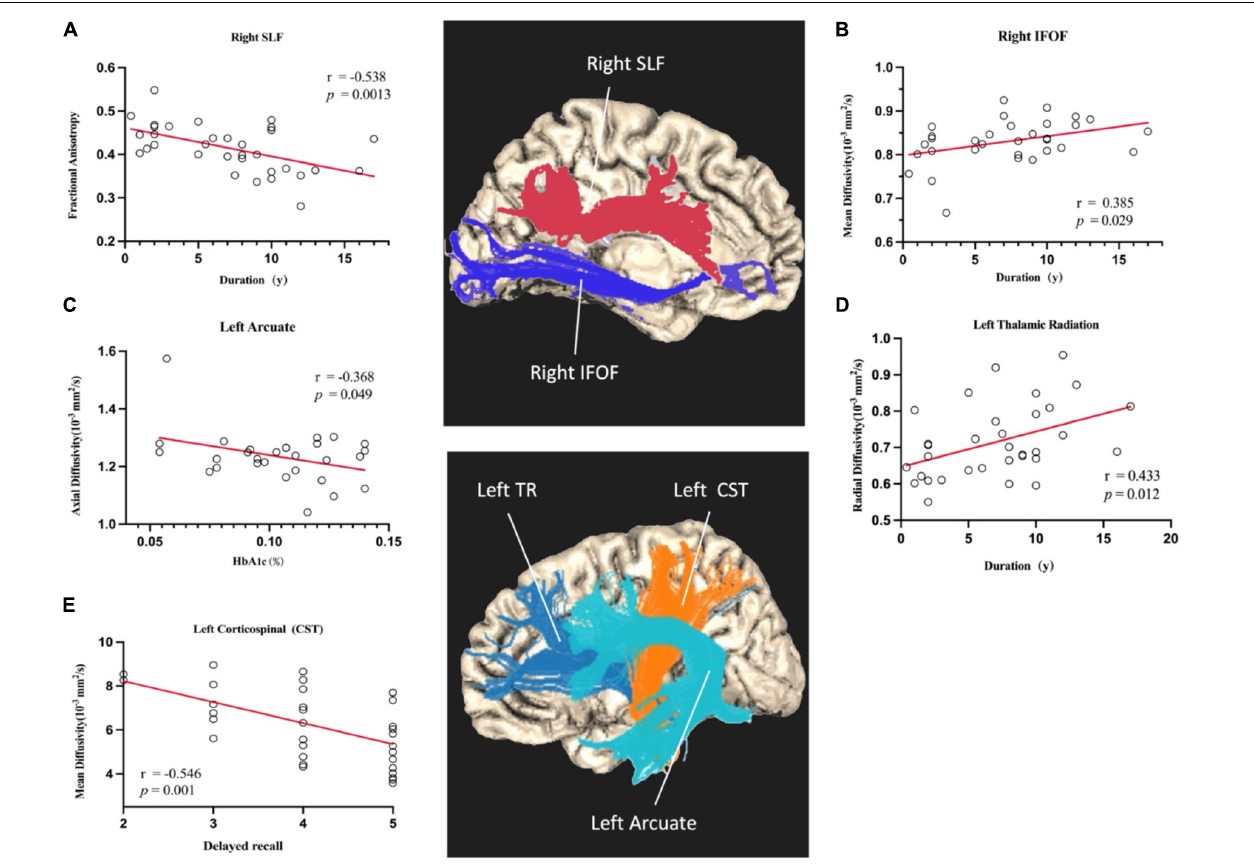
FIGURE 3 | Scatterplots of partial correlation analyses between averaged DTI-derived indexes and HbA 1c , delayed recall, and duration of disease. The red lines are the regression lines controlled for age, gender, and education. Correlation coefficients are noted as r , and p < 0.05 is considered as significant. (A) Shows the duration was negatively correlated with the mean FA of right SLF. (B) Shows the duration was positively correlated with the mean MD of right IFOF. (C) Shows the HbA 1c was negatively correlated with the mean AD of left Arcuate. (D) Shows the duration was positively correlated with the mean RD of left Thalamic Radiation. (E) Shows the delayed recall was negatively correlated with the mean MD of left